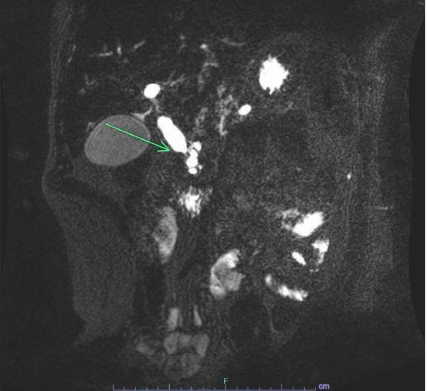
Figure 3: MRI abdomen-enhancing mass in the region of the ampulla, with resulting significant dilation of the biliary tree and the main pancreatic